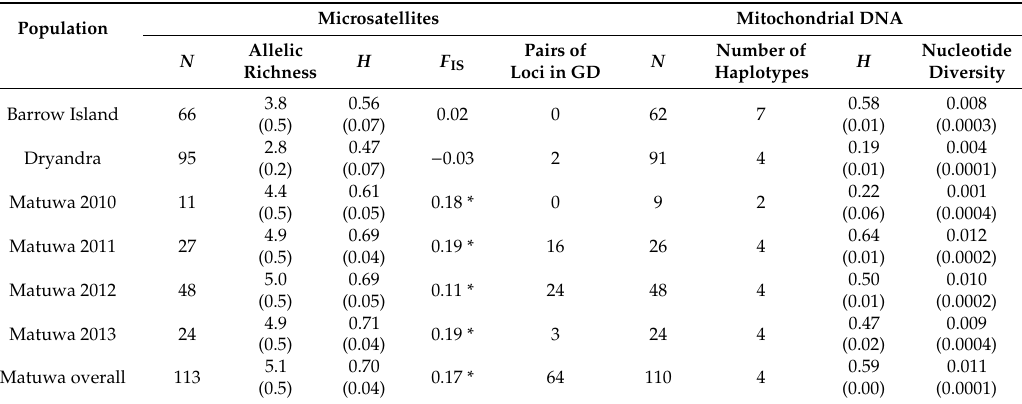
Table 1. Sample sizes, estimates of genetic variation, inbreeding coe ffi cient ( F IS ), and genotypic disequilibrium (GD) in the source (Barrow Island and Dryandra) and translocated populations (Matuwa) based on 12 microsatellite loci. N is the number of samples used in analysis. H is gene diversity. Standard errors are given in brackets after mean values. F IS estimates significantly greater than 0 after correction for multiple comparisons are denoted with an asterisk.